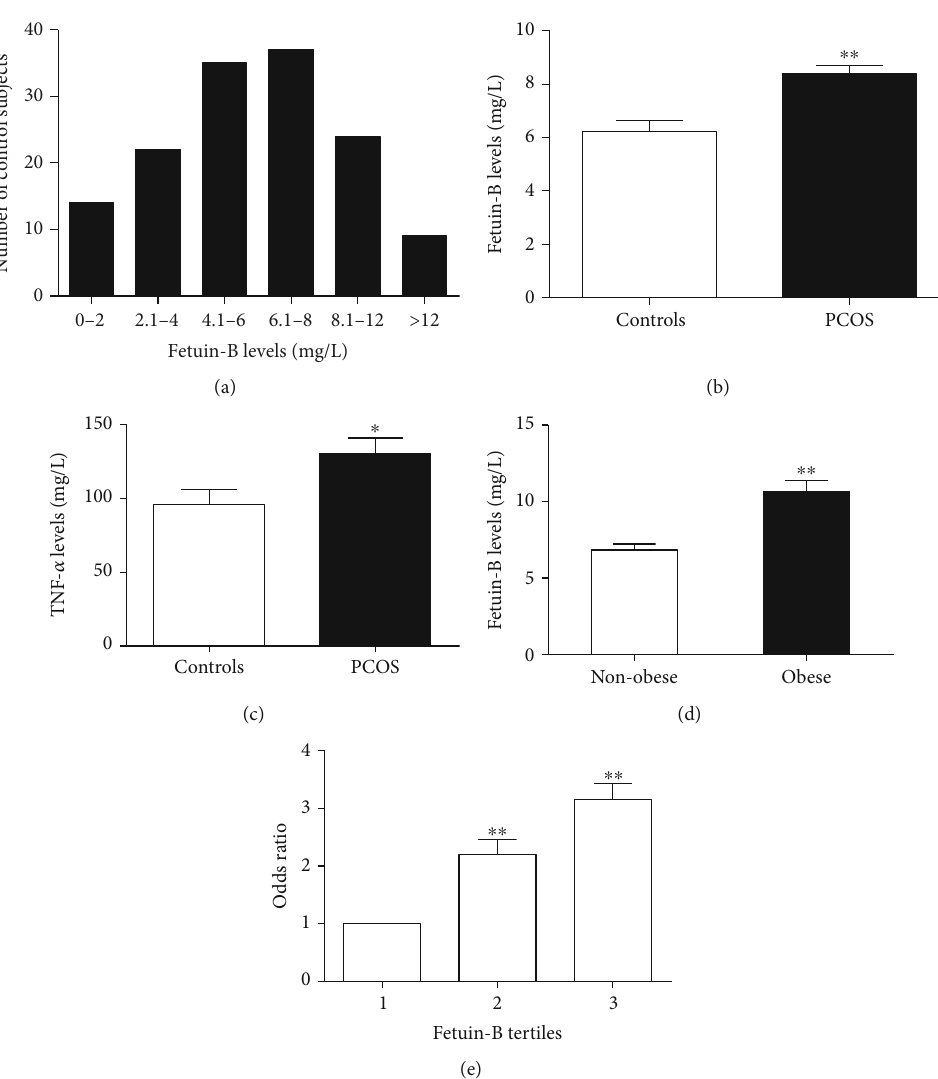
Figure 2: Concentrations of serum Fetuin-B in the study population. (a) Distribution of serum concentration of Fetuin-B in 141 control women. (b) Circulating Fetuin-B levels in PCOS and control women. (c) Circulating TNF α levels in PCOS and control women. (d) circulating Fetuin-B levels according to BMI (lean: BMI < 24 kg/m 2 ; obese: BMI ≥ 28 kg/m 2 ). (e) Prevalence of elevated PCOS in di ff erent quartiles of Fetuin-B. Data are means ± SEM . ∗ p < 0 : 05 or ∗∗ p < 0 : 01 vs. controls, nonobese, or tertile